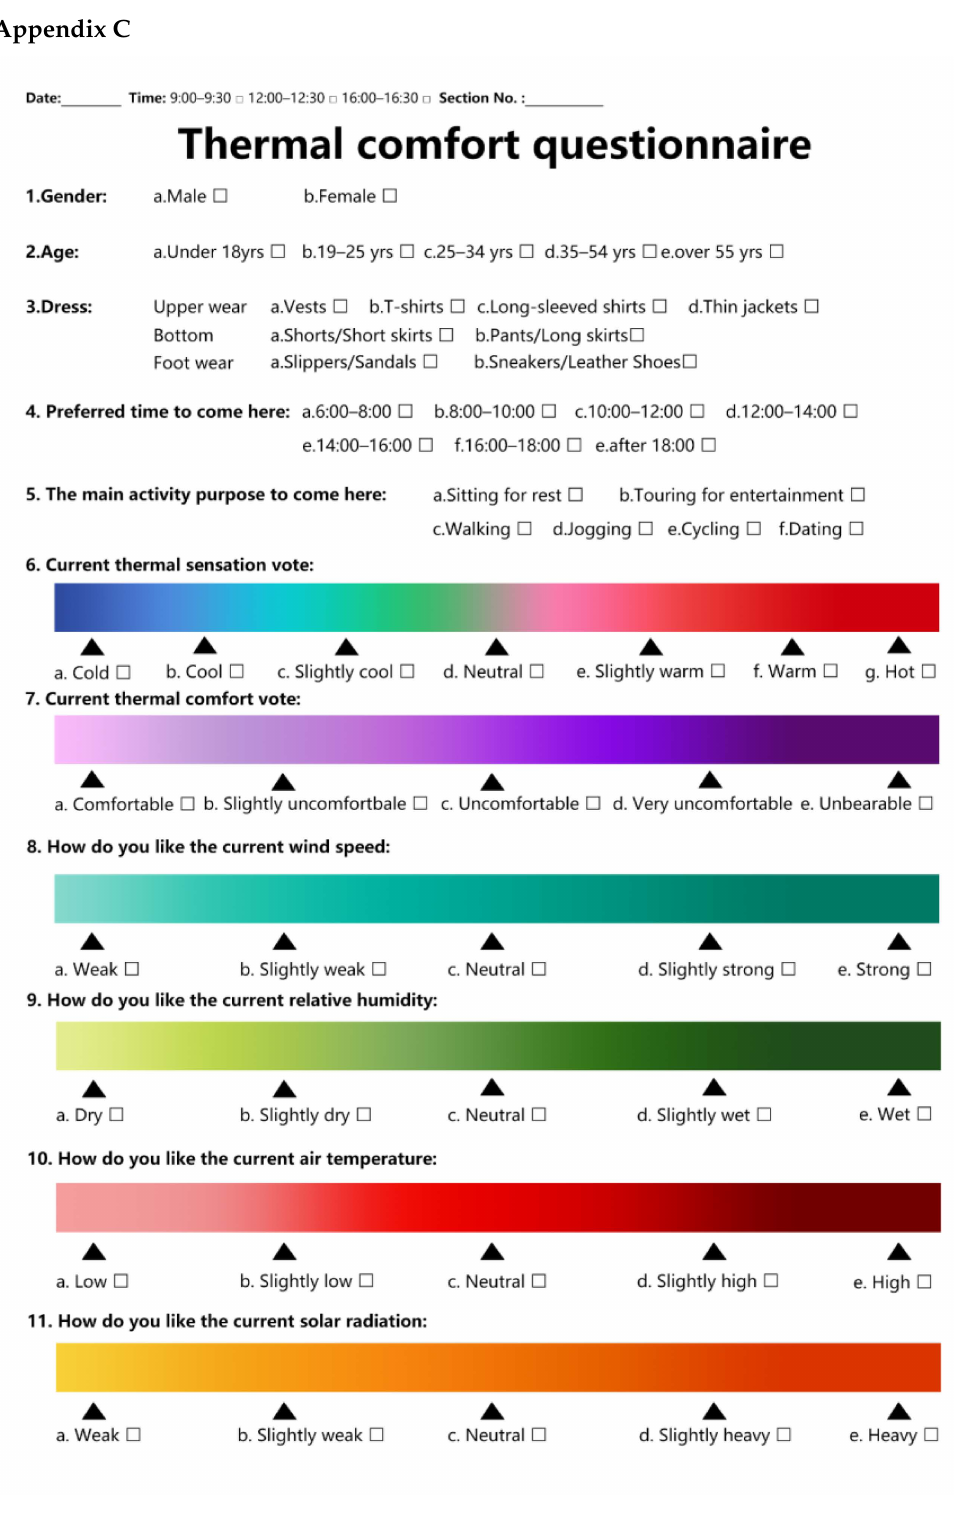
Figure A13. The questionnaire used in the